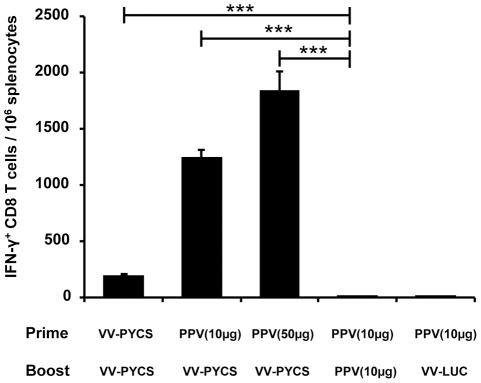
The CS-specific CD8+ T-cell priming effect of PPV-PYCS is markedly enhanced by boosting with replication competent VACV vector expressing CS.Different groups of BALB/c mice (5 per group) were immunized s.c with 10 or 50 µg of PPV-PYCS [PPV(10 µg) and PPV(50 µg) respectively] or with VACV vectors in prime/boost protocols. Fourteen days after the boost CS-specific IFN-γ secreting cells for the plasmodial epitope SYVPSAEQI in splenocytes were measured by ELISPOT as described under Materials and Methods. The results are expressed as the mean of triplicate assays using cultured pooled splenocytes. Statistical values were determined by one-way ANOVA; P values, *P<0.05, **P<0.01, ***P<0.001.